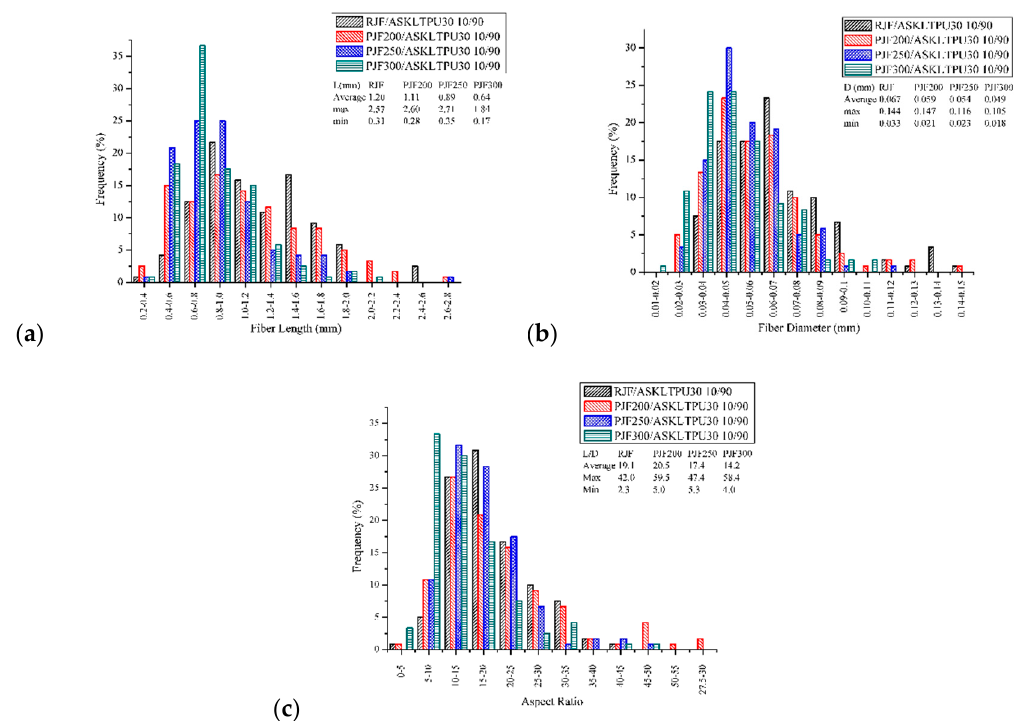
Figure 5. Variations of the ( a ) length; ( b ) diameter; and ( c ) aspect ratio of JFs in JF-reinforced ASKLTPUs.